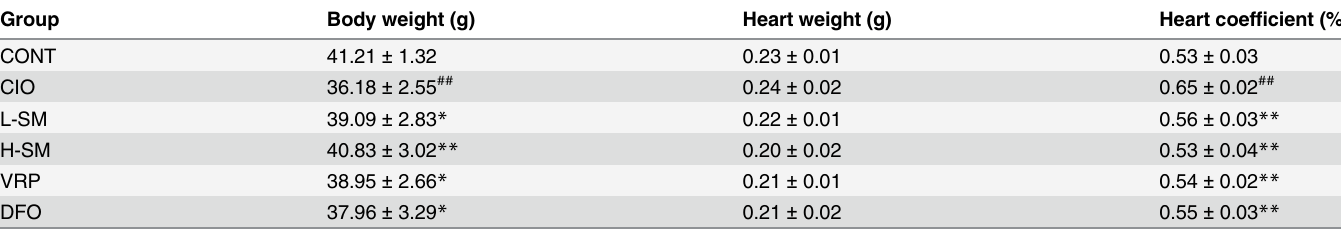
Table 1. Effects of SM on body weight, heart weight and heart